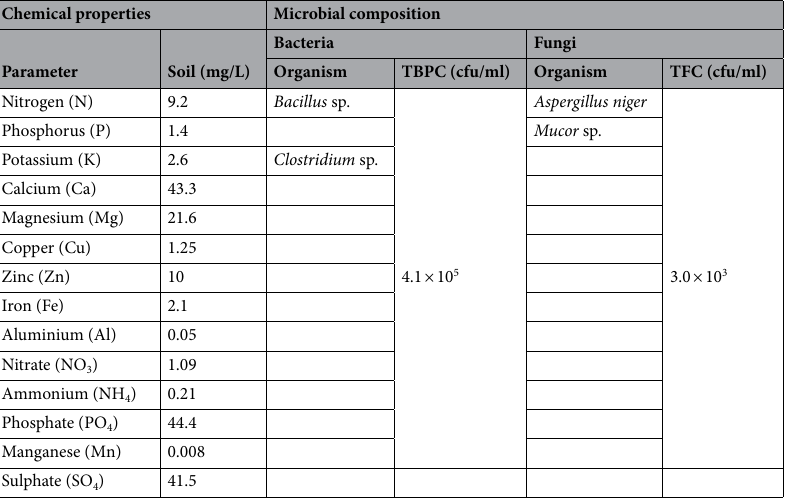
Table 2. Soil physicochemical properties and microbial composition. TBPC total bacterial plate count, TFC total fungal count.